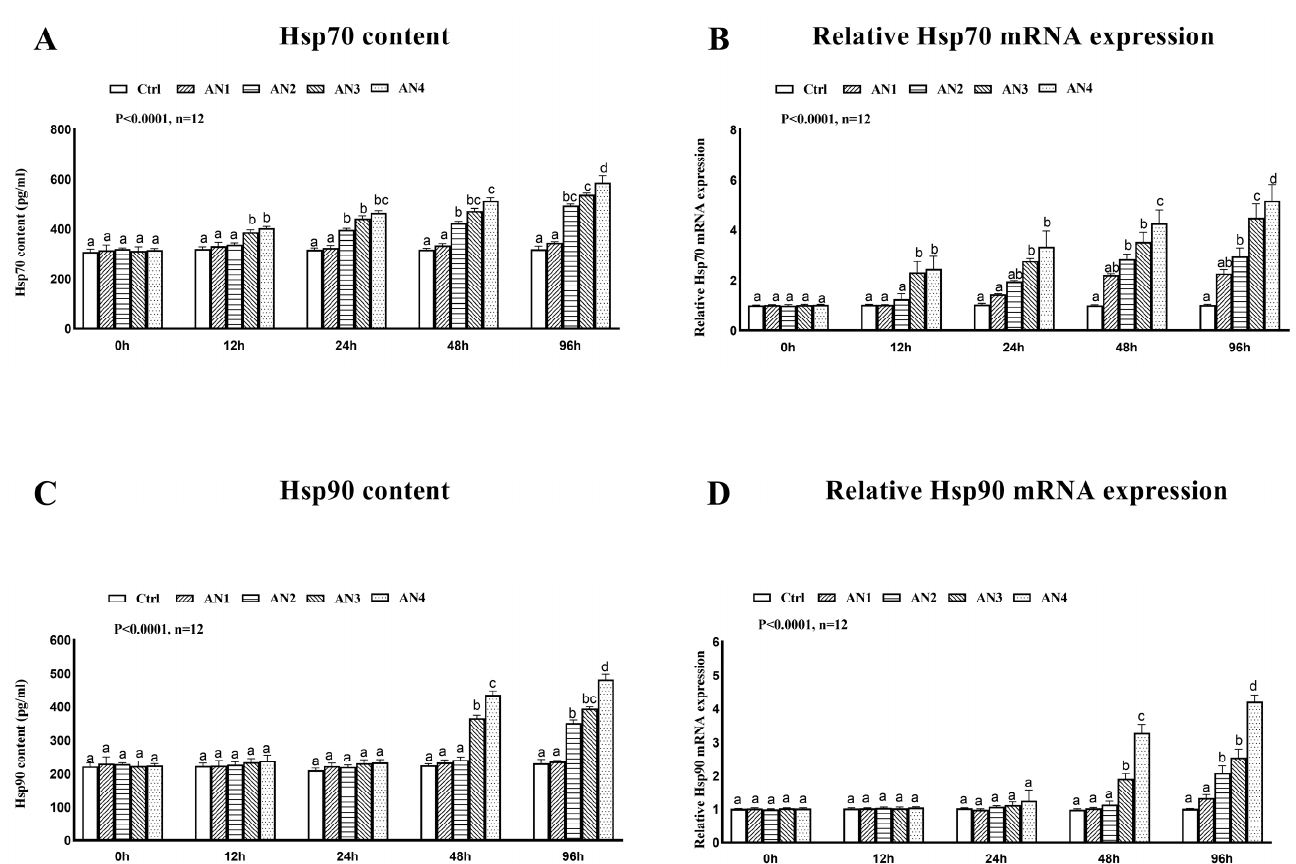
Figure 5. Changes of stress-related hormones in bighead carp exposed to ammonia. ( A ) Plasma cor- tisol, ( B ) glucose (Glu), ( C ) adrenaline, and ( D ) 3 ′ -triiodothyronine (T3). Values are expressed as mean ± standard error (SE) from triplicate groups ( n = 12). Bars with different letters (a, b, c, d, e) differ significantly from those of other groups ( p < 0.05).